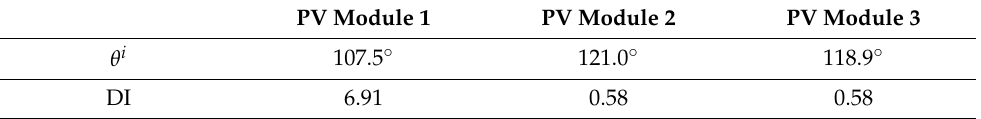
Table 2. Module orientation and DI (situation in which there is one tracker with a vertical fault).